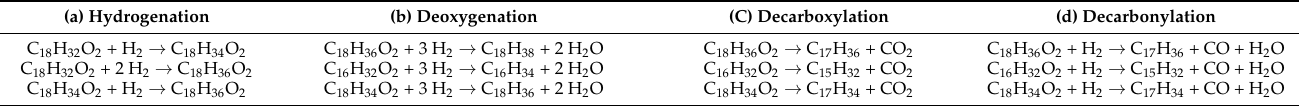
Table 11. The chemical reaction of Jatropha’s fatty acid saturation and